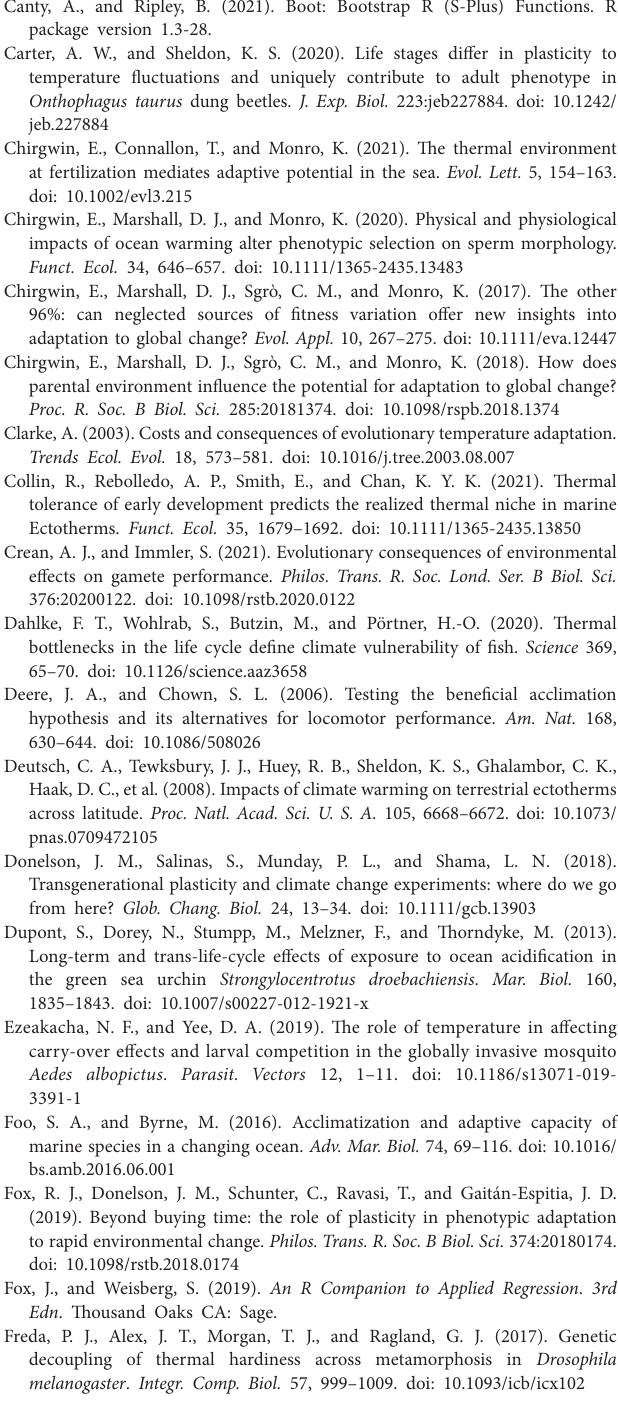
Supplementary Figure S1 | Proportions of individuals that successfully survived planktonic development after fertilization at 18 or 22 ° C and embryogenesis at 18, 20, or 22 ° C. Points are mean success (with bars indicating 95% CIs) and curves are locally-weighted smoothers (with shaded areas indicating 95% CIs) that assume no particular